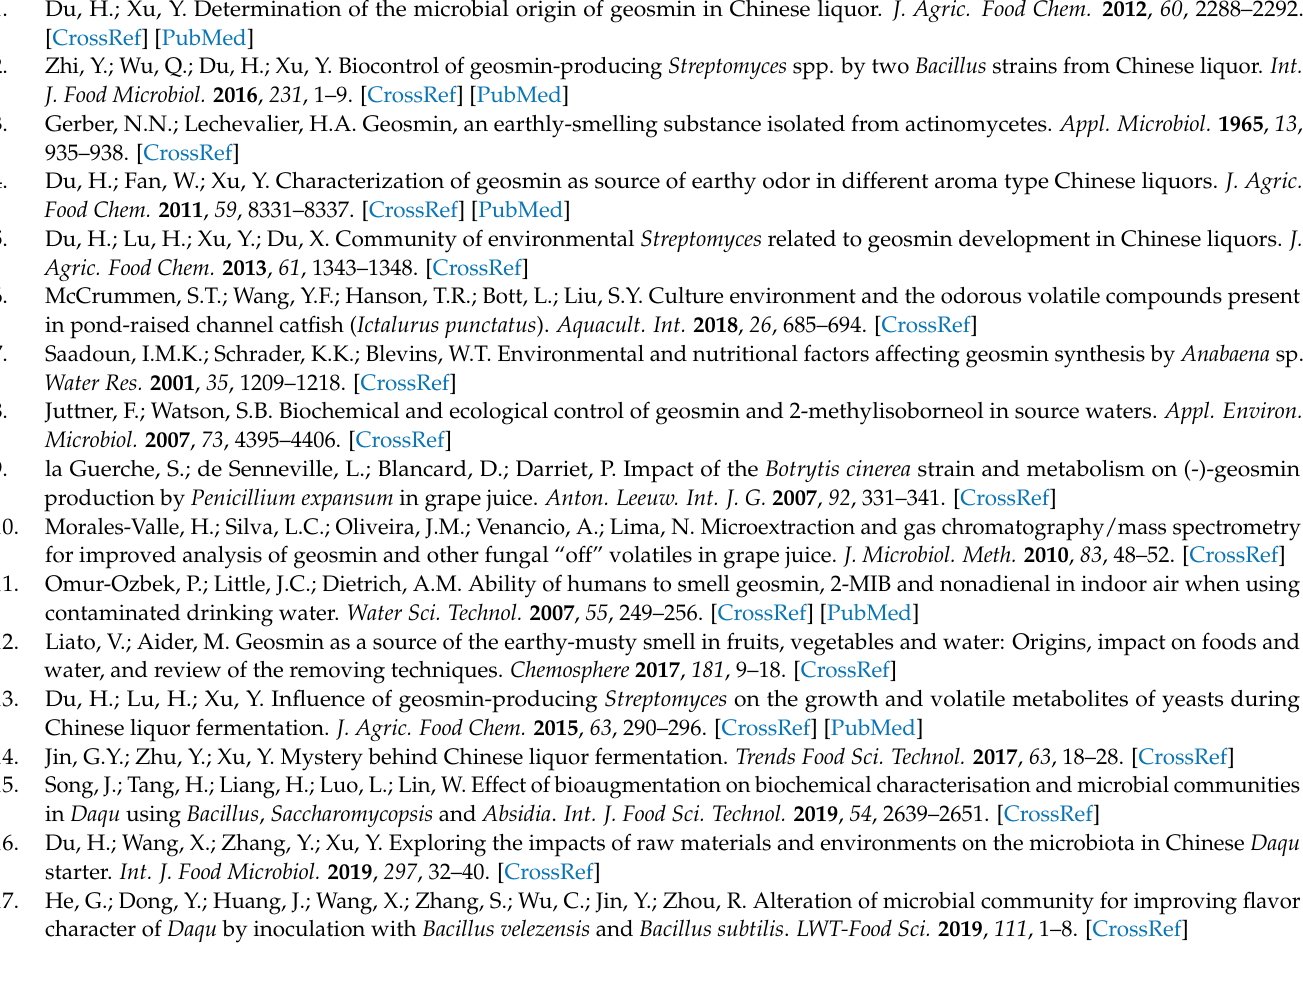
Daqu ; Table S3: Chao1 index values for fungal and bacterial communities in Daqu ; Table S4: Shannon index values for fungal and bacterial communities in Daqu ; Table S5: Microbial community structure during Daqu fermentation; Table S6: Table sThe contents of volatile compounds between test group and control